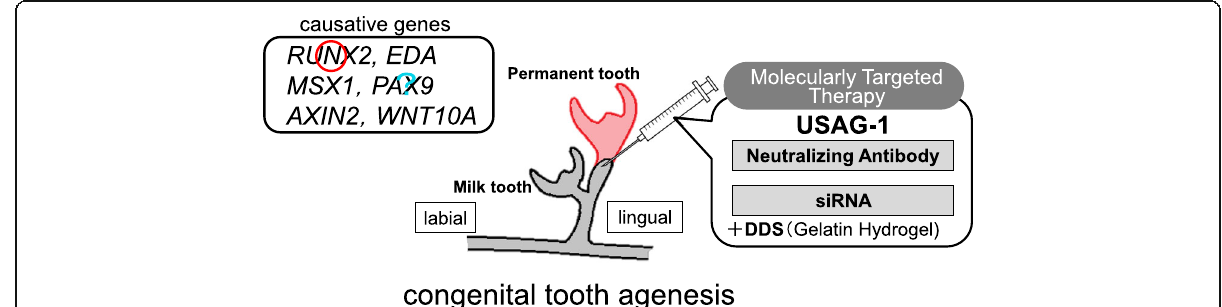
Fig. 1 Treatment plan for congenital tooth agenesis. RUNX2, EDA, MSX1, PAX9, AXIN2, and WNT10A have been identified as causative genes for congenital tooth agenesis. The mutation of the causative gene is used as a biomarker, and a neutralizing antibody of USAG-1 or USAG-1 siRNA is administered as a molecularly targeted drug